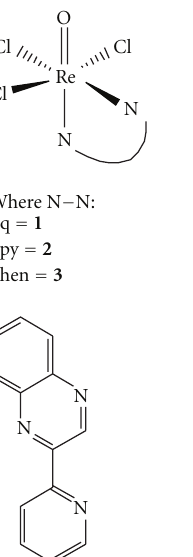
and 1-10-phenanthroline (6) belong to quinoxaline or diimine class of organic compounds (Figure